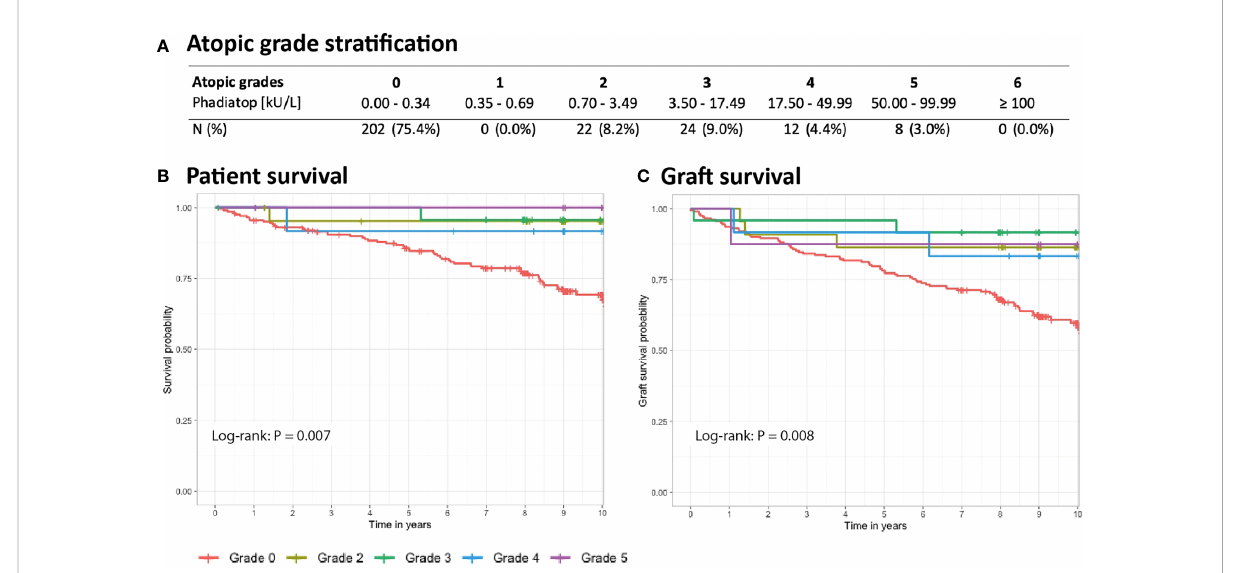
FIGURE 2 Kaplan-Meier estimates of ten-year follow-up strati fi ed by atopic grade. (A) Number of patients in each subgroup based on Phadiatop grading. (B) Patient survival and (C) graft survival across all groups. The calculated p-values were obtained by the log-rank test (univariate analysis).